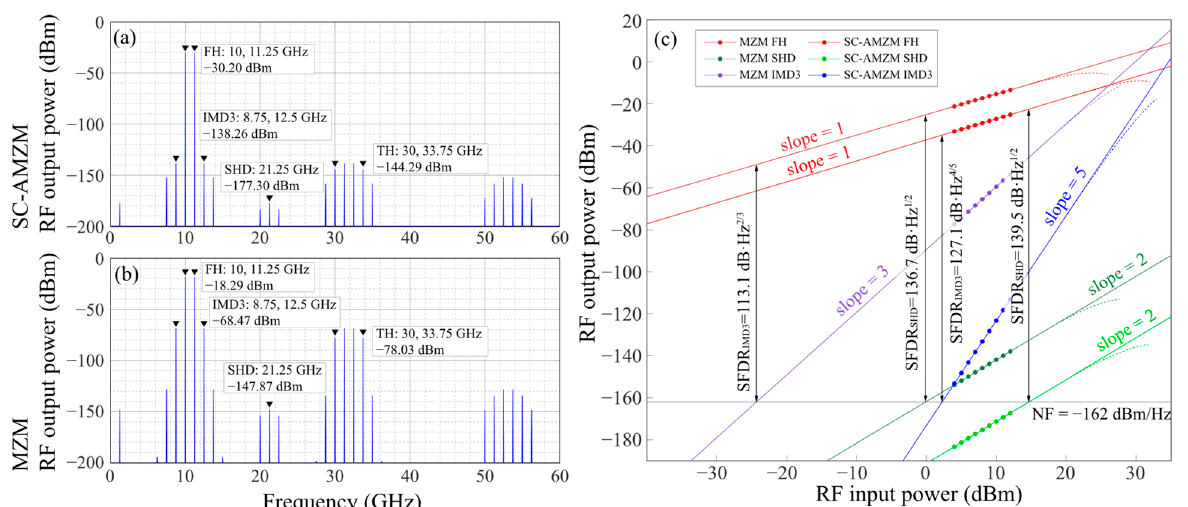
Figure 6. Spectrogram of ( a ) CS-AMZM and ( b ) MZM under ideal conditions. ( c ) Simulated SFDR results of the standard MZM and the proposed CS-AMZM. The dashed line shows the actual output power for large input